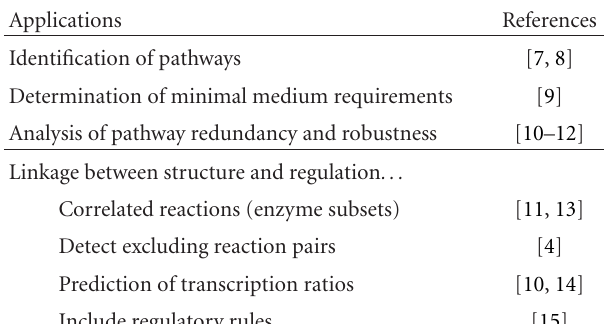
Table 1: Applications of network-based pathways analysis. Partially extracted from [4–6].